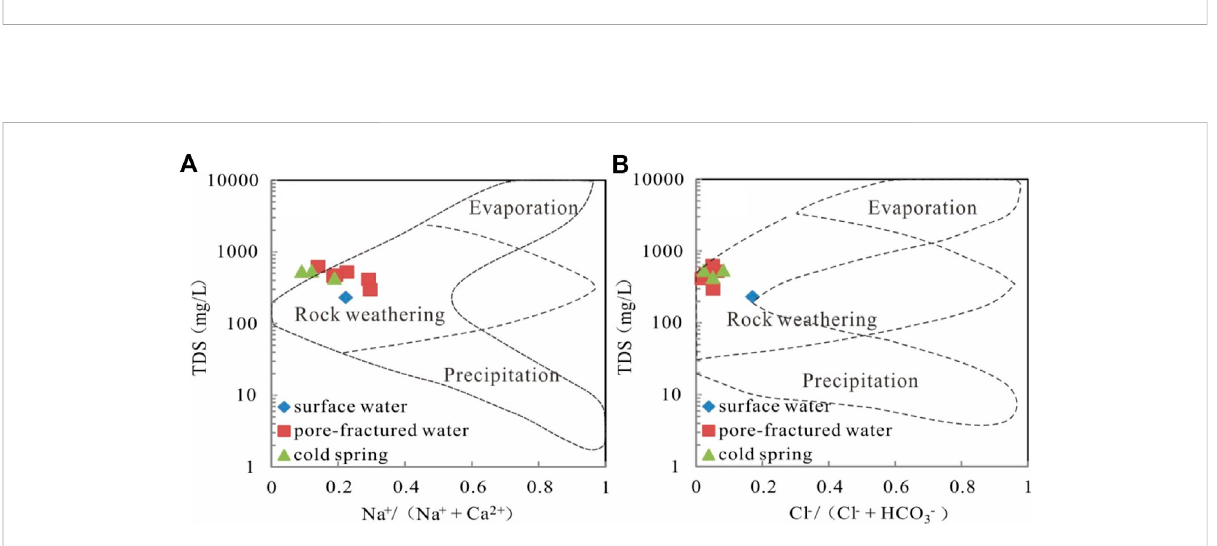
FIGURE 3 TDS versus (A) Na + /(Na + + Ca 2+ ) and (B) Cl − /(cl − + HCO 3 −